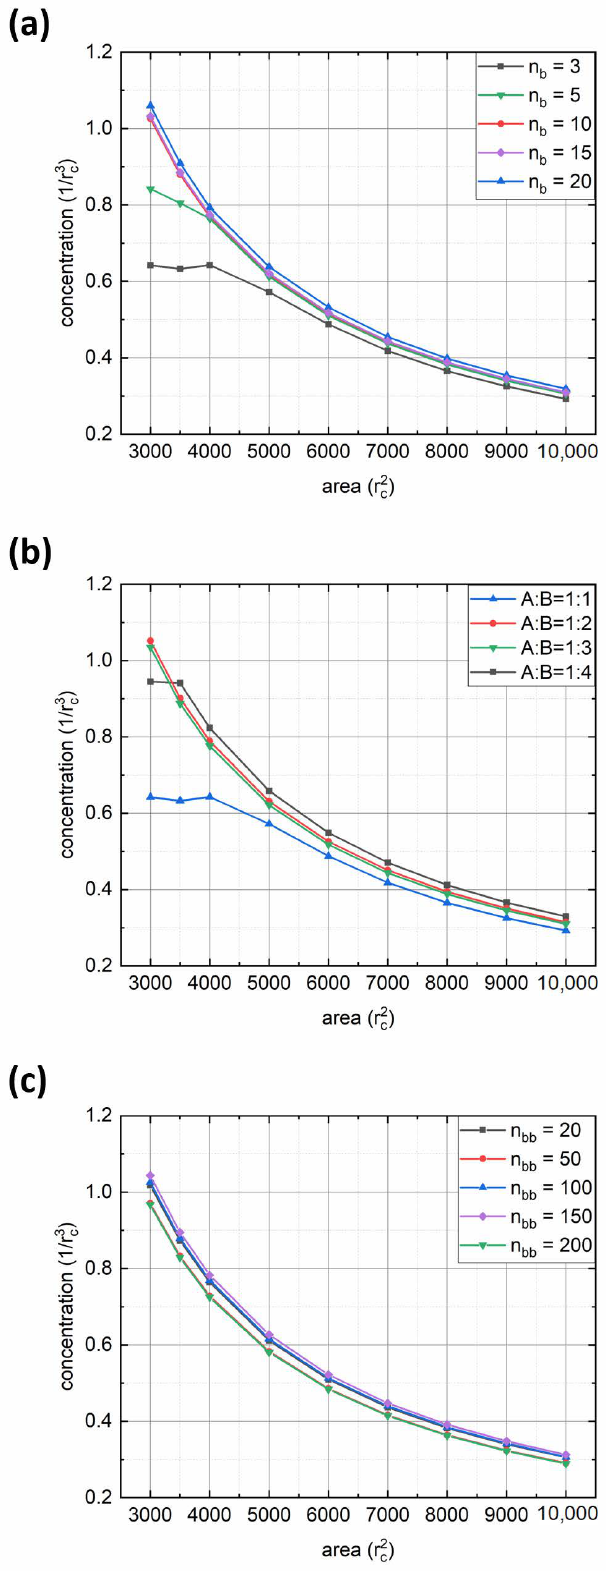
Figure 7. Dependences of polymer concentration in the monolayer on the interfacial area at different: ( a ) solvophobic side chain length ( n bb = 100 and f a = 0.5); ( b ) ratio between solvophilic and solvophobic side chains A:B ( n b = 3 and n bb = 100); and ( c ) backbone length ( n b = 10 and f a =